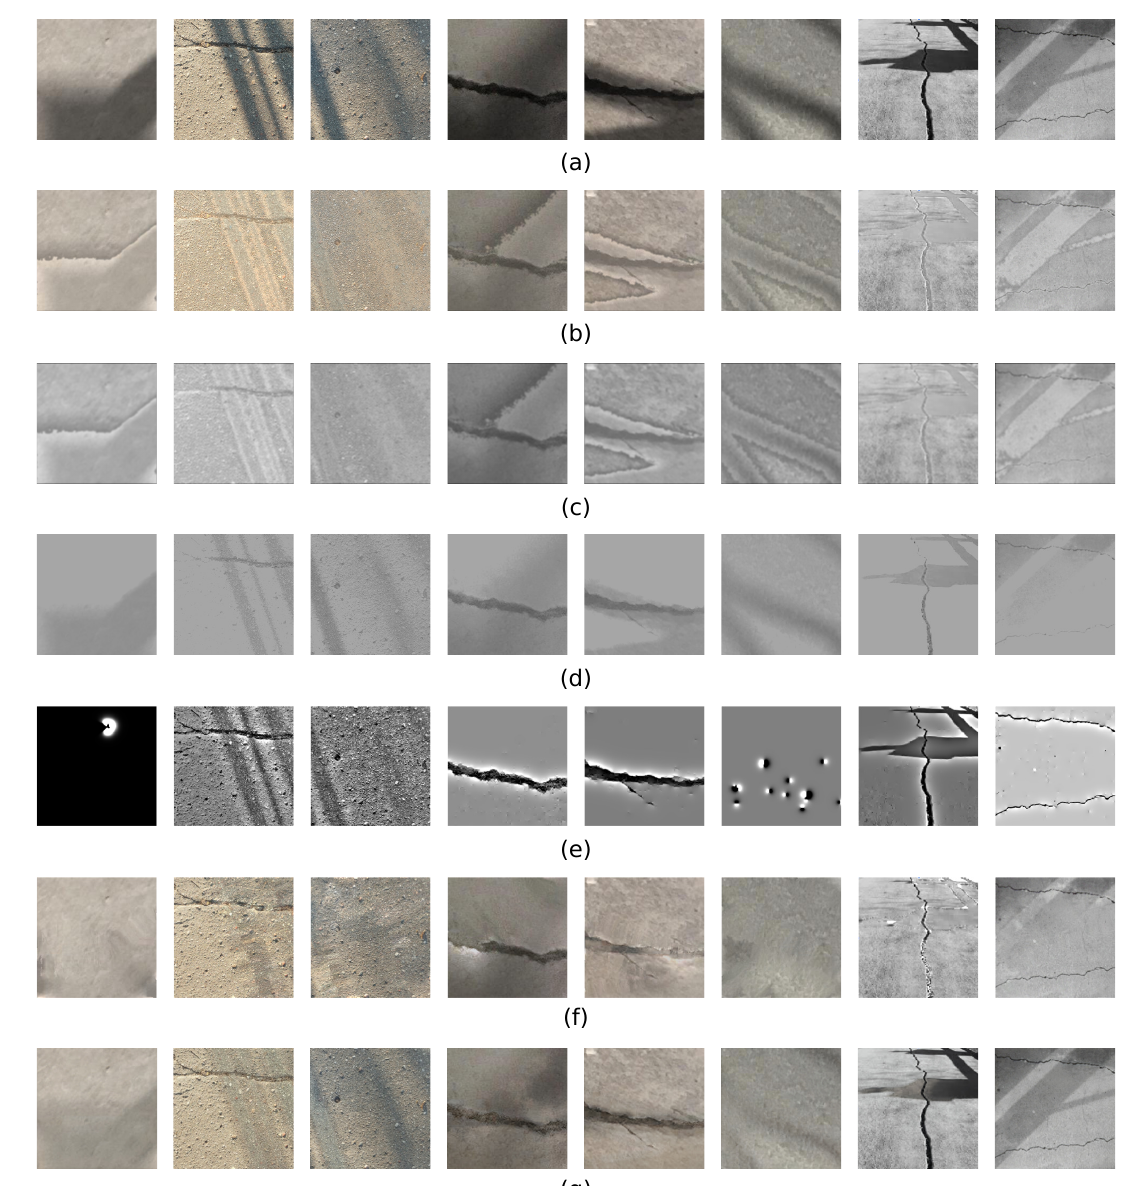
Figure 7. The comparison of different methods for shadow removal from concrete images with cracks and without cracks: original concrete images with shadows are shown in part ( a ), application of the shadow removal methodology proposed in [34] is shown in part ( b ), shadow detection and removal using mean and Gaussian filtering is shown in part ( c ), application of color-model based shadow detection and removal technique [44] is shown in part ( d ), application of the non-local retinex model [45,46] is shown in part ( e ), application of interactive removal and ground truth for difficult shadow scenes [47] is shown in part ( f ), and ghost-free shadow removal via dual hierarchical aggregation network and shadow matting GAN [48] is shown in part ( g ).